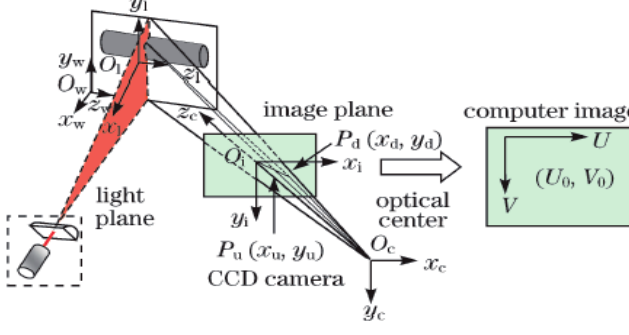
Figure 4. Mathematical model of the system (with permission from